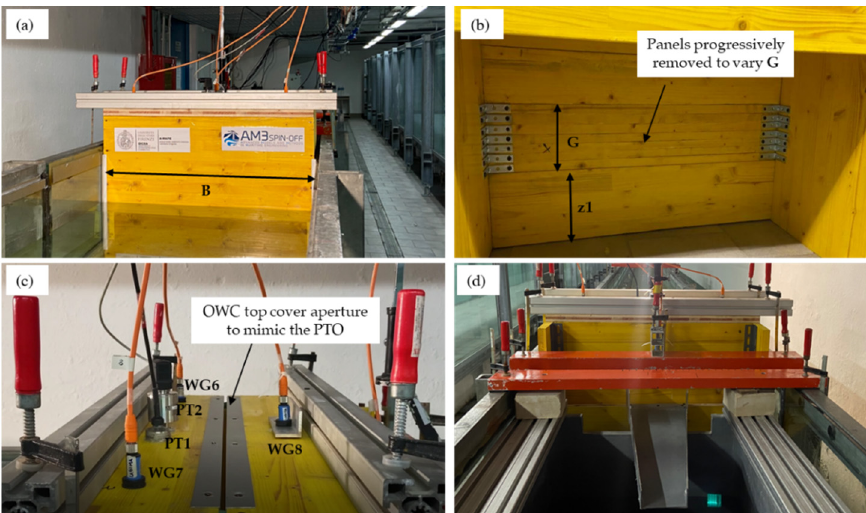
Figure 2. The 1:25 scaled model of the O 2 WC installed in LABIMA wave-current flume ( a ); detail of the OWC chamber back wall, with the different panels used to vary the size of the submerged opening G during the tests ( b ); the sensors installed on the top cover of the OWC chamber (WG: wave gauge, PT: pressure transducer) and the slot mimicking the PTO pressure drop ( c ); detail of the overtopping collecting ramp installed in the OTD chamber ( d ).